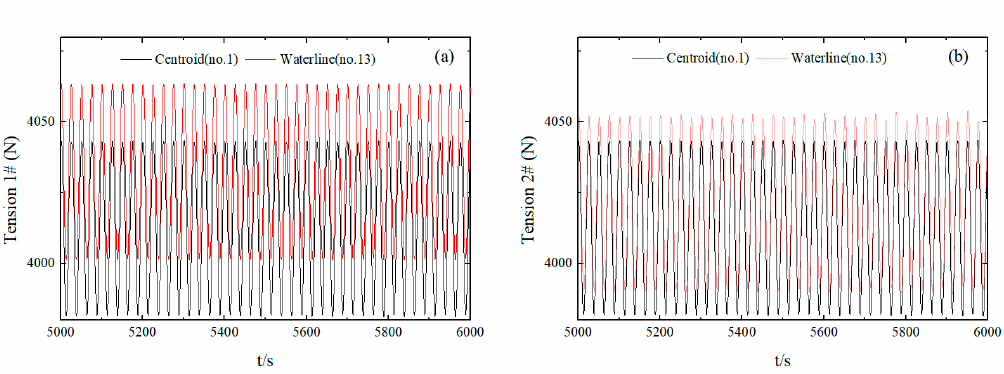
Figure 12. Time-history tension curves for the float chain with different mooring points. (Sub-figures: ( a ) time-history curves of anchor chain I tension; ( b ) time-history curves of anchor chain II tension.).